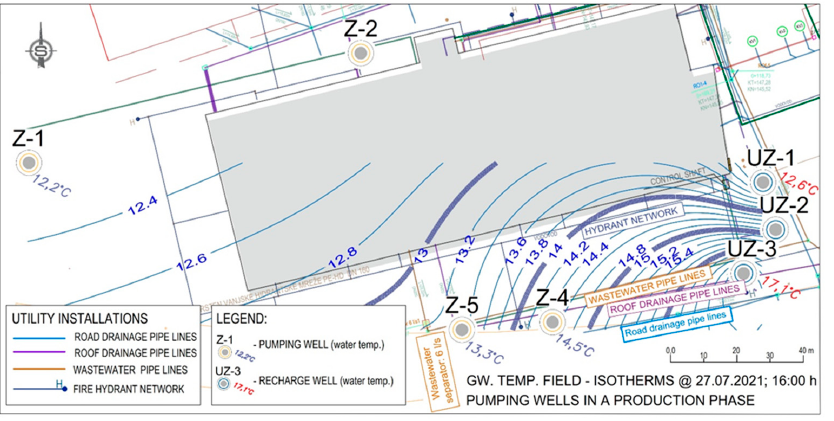
Figure 25. The state of the temperature distribution (thermal field) for the regular mode of operation on 27 July 2021 at 16:00.